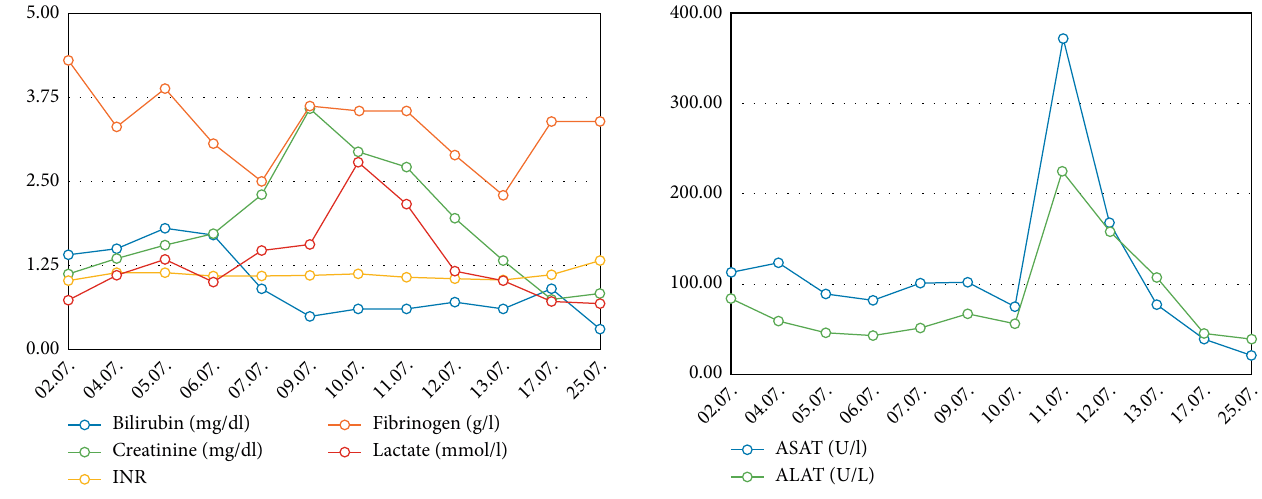
Figure 3: Different laboratory parameters over time. INR: International normalized ratio.